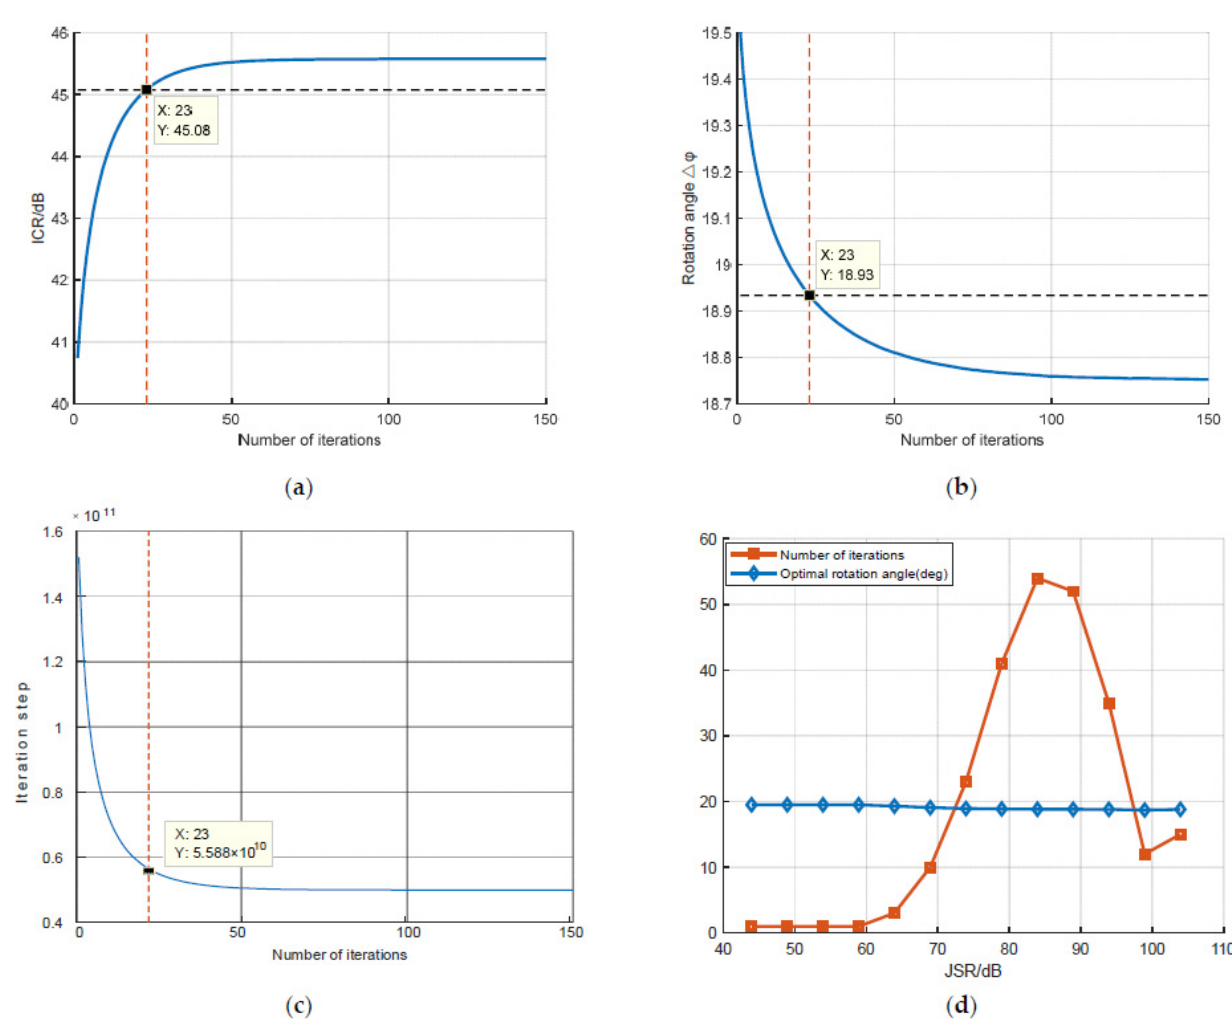
Figure 12. The effect of the proposed variable-step iteration algorithm. ( a ) The relationship between the ICR and the number of iterations. ( b ) The relationship between the optimal rotation angle and the number of iterations. ( c ) The relationship between the iteration step and the number of iterations. ( d ) The relationship between the number of iterations and the interference intensity.